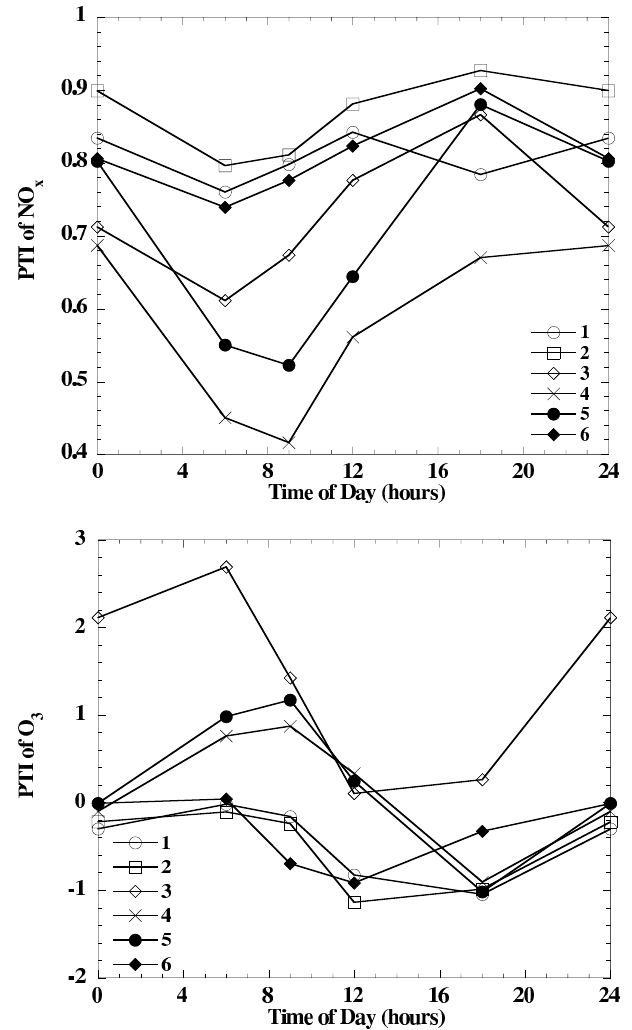
Fig. 16. Diurnal variations of PTI NO (top panel) and PTI O (bot- x 3 tom panel) in July at 50 ◦ N for different conditions: 1: lower stratosphere, inside NAFC, T = 222K, P plume; 2: upper tropo- sphere, inside NAFC, T = 222K, P plume; 3: upper troposphere, outside NAFC, T = 222K, P plume; 4: lower stratosphere, in- side NAFC, T = 233K, P plume; 5: upper troposphere, inside NAFC, T = 233K, P plume; 6: upper troposphere, inside NAFC, T = 233K, S plume. Reprinted from Karol et al. (2000). An edited version of this paper was published by AGU. Copyright (2000) American Geophysical